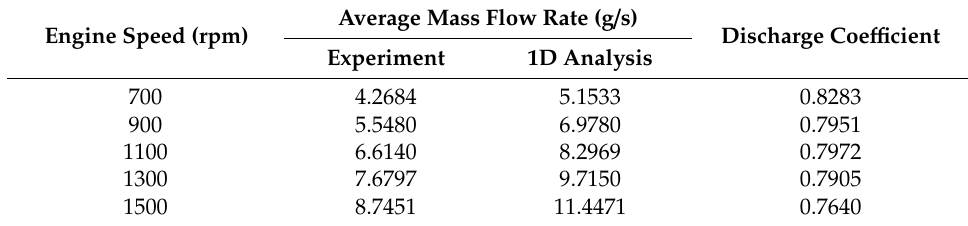
Figure 5. Average mass flow rate and discharge coefficient of intake air . Table 4. Comparison of the average mass flow rate and the discharge coefficient according to the engine speed.